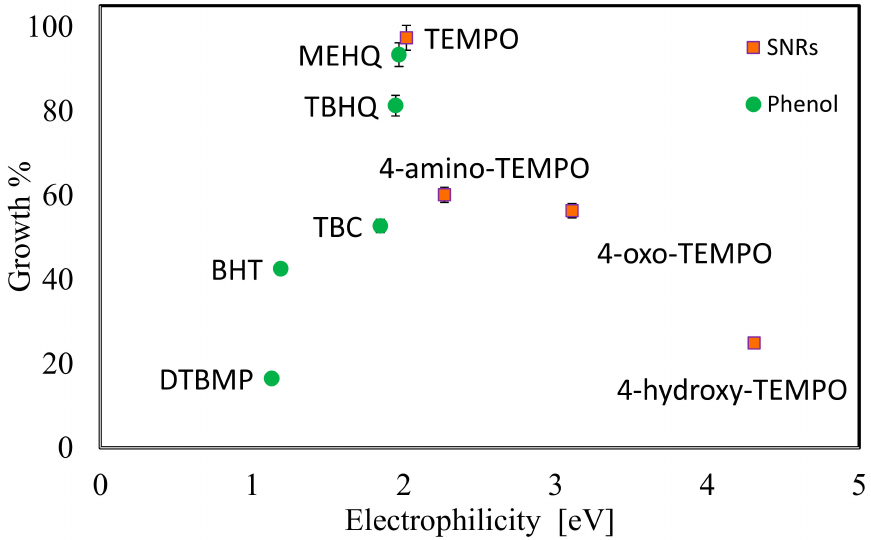
Figure 8. Calculated electrophilicity and measured growth percentage after 4 h of SNRs and